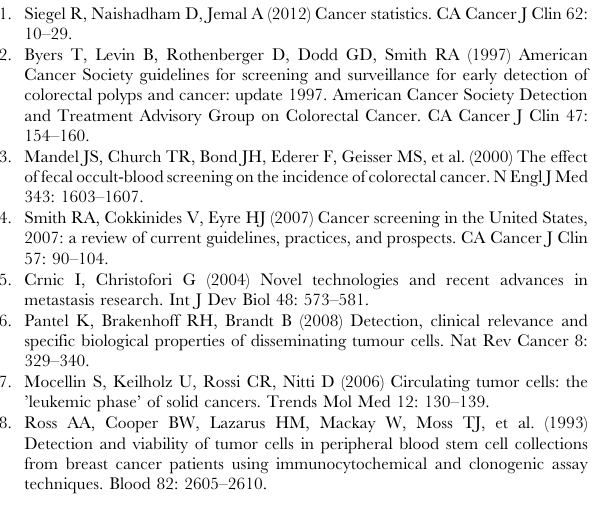
patients using two different